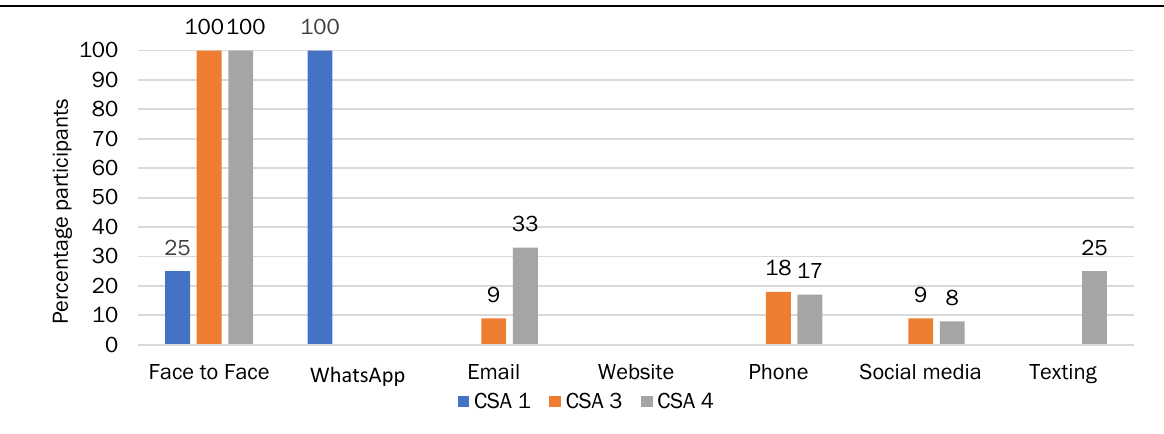
Figure 4. Type of Media Used by Participants to Communicate with Other